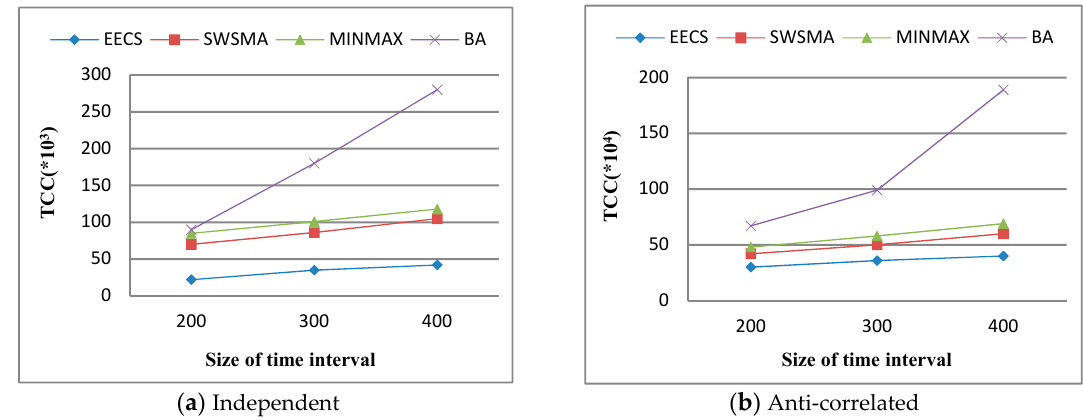
Figure 7. Performance vs. size of query time interval.